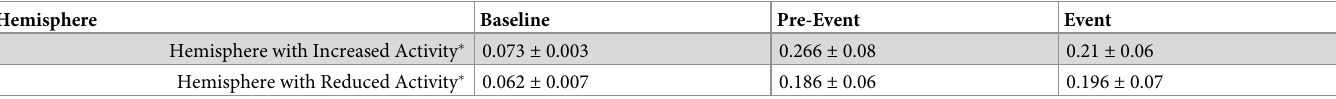
Data represents mean ± SEM fourier transformed normalised power. � = Visible on topoplot (FieldTrip